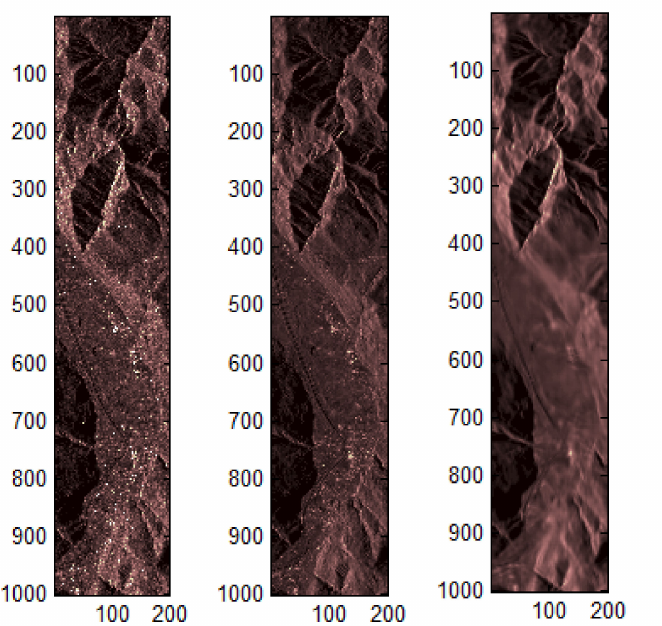
Figure 8. Zoom in, original image (left), first stage result (center) and final result